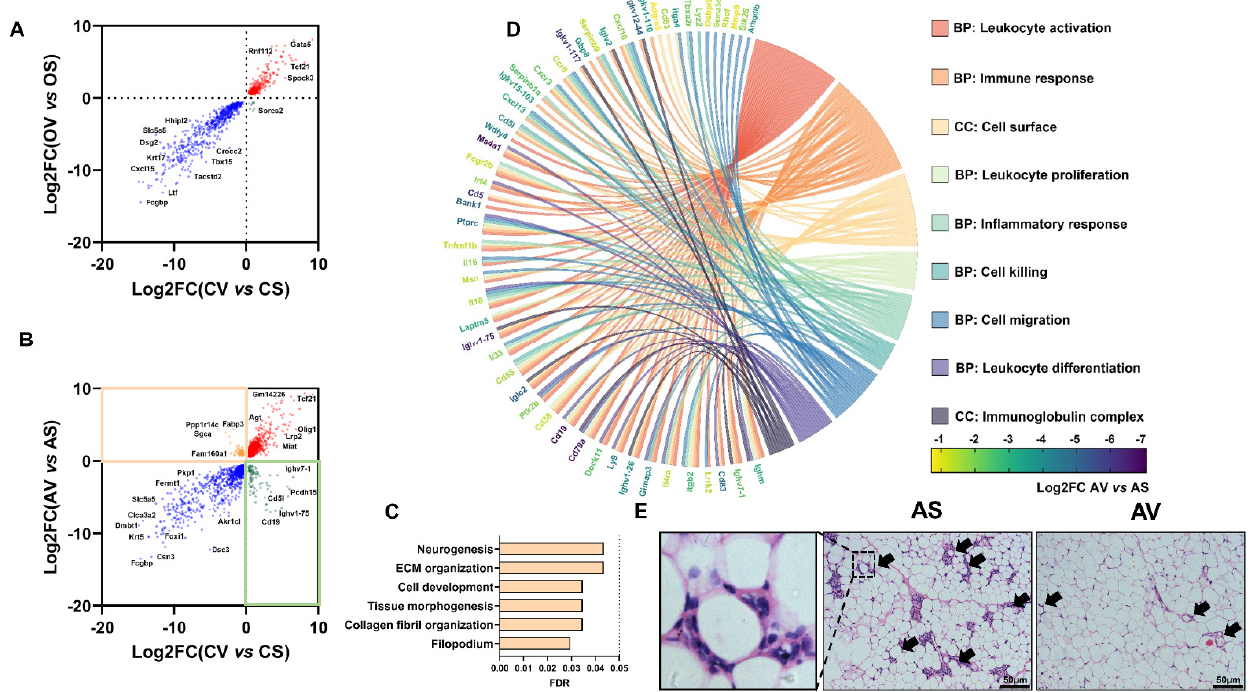
Figure 6. ADX, but not OVX, reverses the intrinsic difference between SAT and VAT in female mice. ( A ) The common regulated genes in SAT and VAT by OVX. ( B ) The common regulated genes in SAT and VAT by ADX. ( C ) Functional enrichment analysis of DEGs which originally were less expressed in VAT than SAT in the sham controls, but reversed by ADX. ( D ) Functional enrichment analysis of DEGs which originally were highly expressed in VAT than SAT in the sham controls, but reversed by ADX. ( E ) Representative histological images of SAT and VAT of ADX mice. Arrows indicate crown-like structures. Scale bar: 50 μ m.